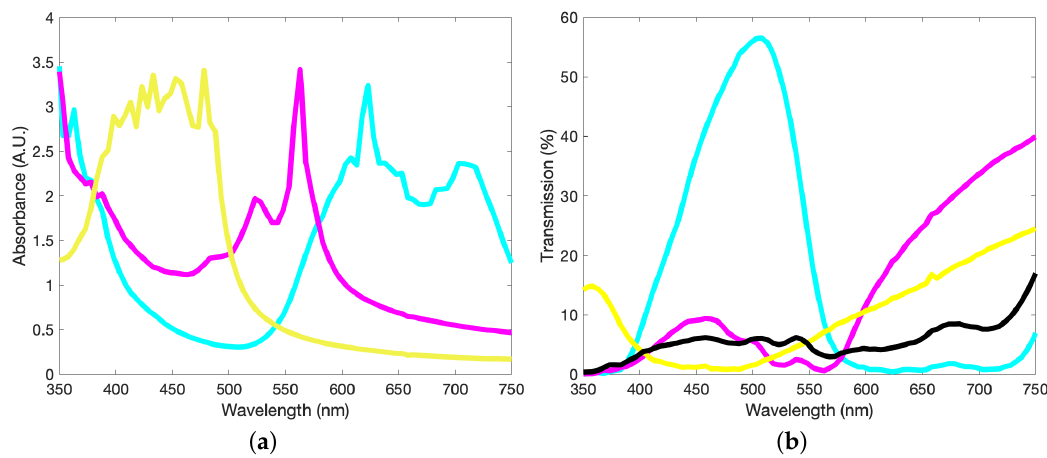
Figure 2. ( a ) Absorbance values for the cyan, magenta and yellow pigments in aqueous solution. We average over a 5 nm interval to minimise the noise of the output. No gelatin is present here; the inks are derived from a diluted version of the recipe detailed in the text. ( b ) Corresponding transmission values of the three pigments. Also shown in black is the transmission of an equal mixture of 1/3 : 1/3 : 1/3 of the three pigments, included to show the “near-black” alternative provided a direct combination of the three